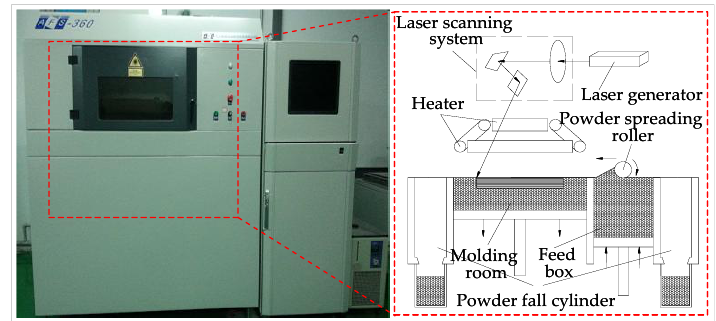
Figure 3. Equipment for selective laser sintering (SLS) and schematic diagram of the process.